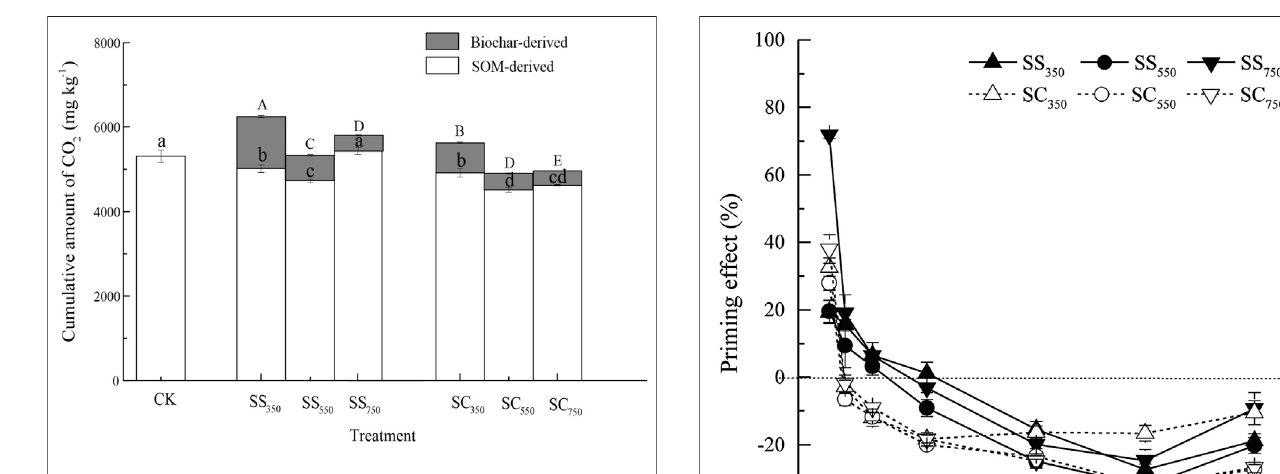
FIGURE 1 | Cumulative amount of CO 2 derived from two sources with different biochars. Data are mean ± standard deviation ( n (cid:2) 3). Blank and grey bars represent the cumulative amount of CO 2 derived from native SOM and biochars, respectively. Their signi fi cant differences among different treatments were also indicated by lowercase and uppercase letters, respectively (at p < 0.05 level). CK: the soil with no amendment as